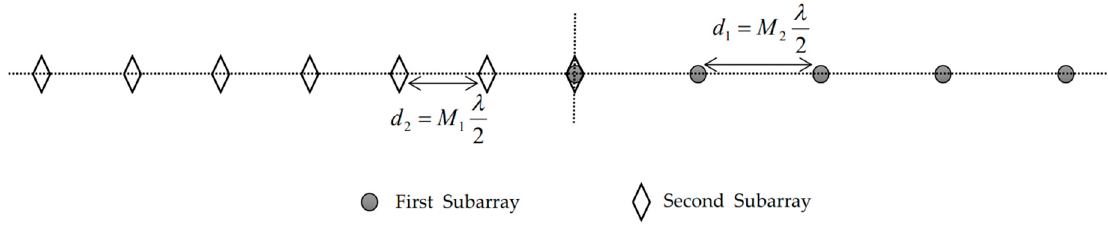
Figure 1. System model.